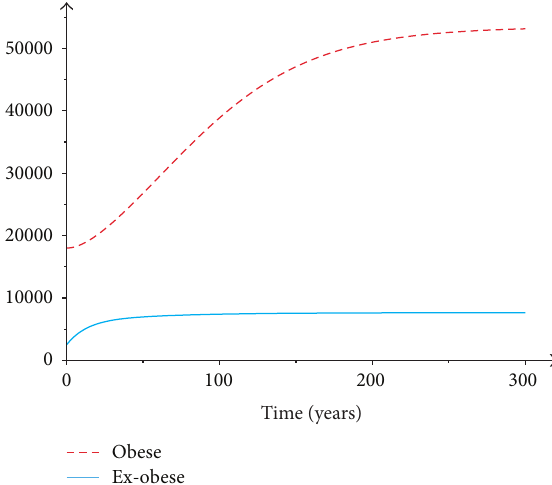
Figure 13: Infected (obese) and recovered (ex-obese) individuals as function of time. Here 𝜖 = 0 , 𝑅 0 = 1 , and the initial condition is (𝐼(0), 𝑅(0)) = (18000, 2500) .